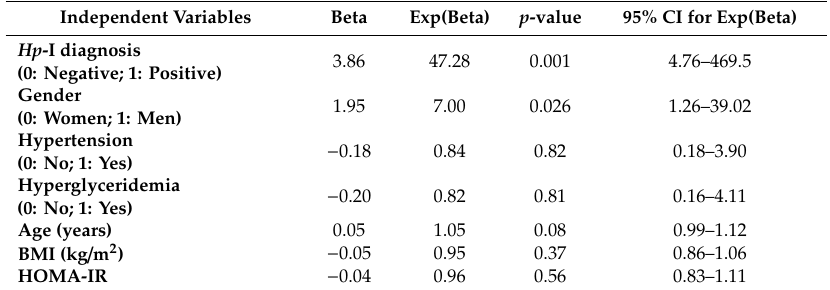
Table 4. Independent associates of fibrosis (F0 vs. F1-3) in binary logistic regression